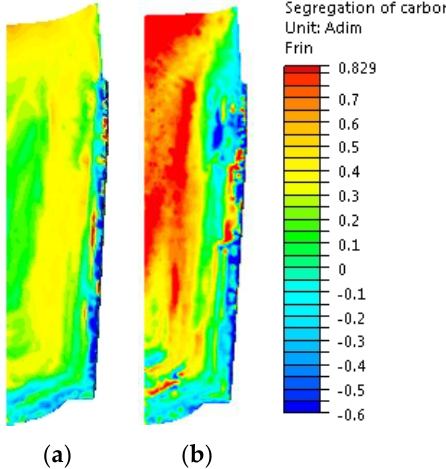
Figure 11. Segregation pattern of carbon predicted using ( a ) Lever rule; ( b ) Scheil.